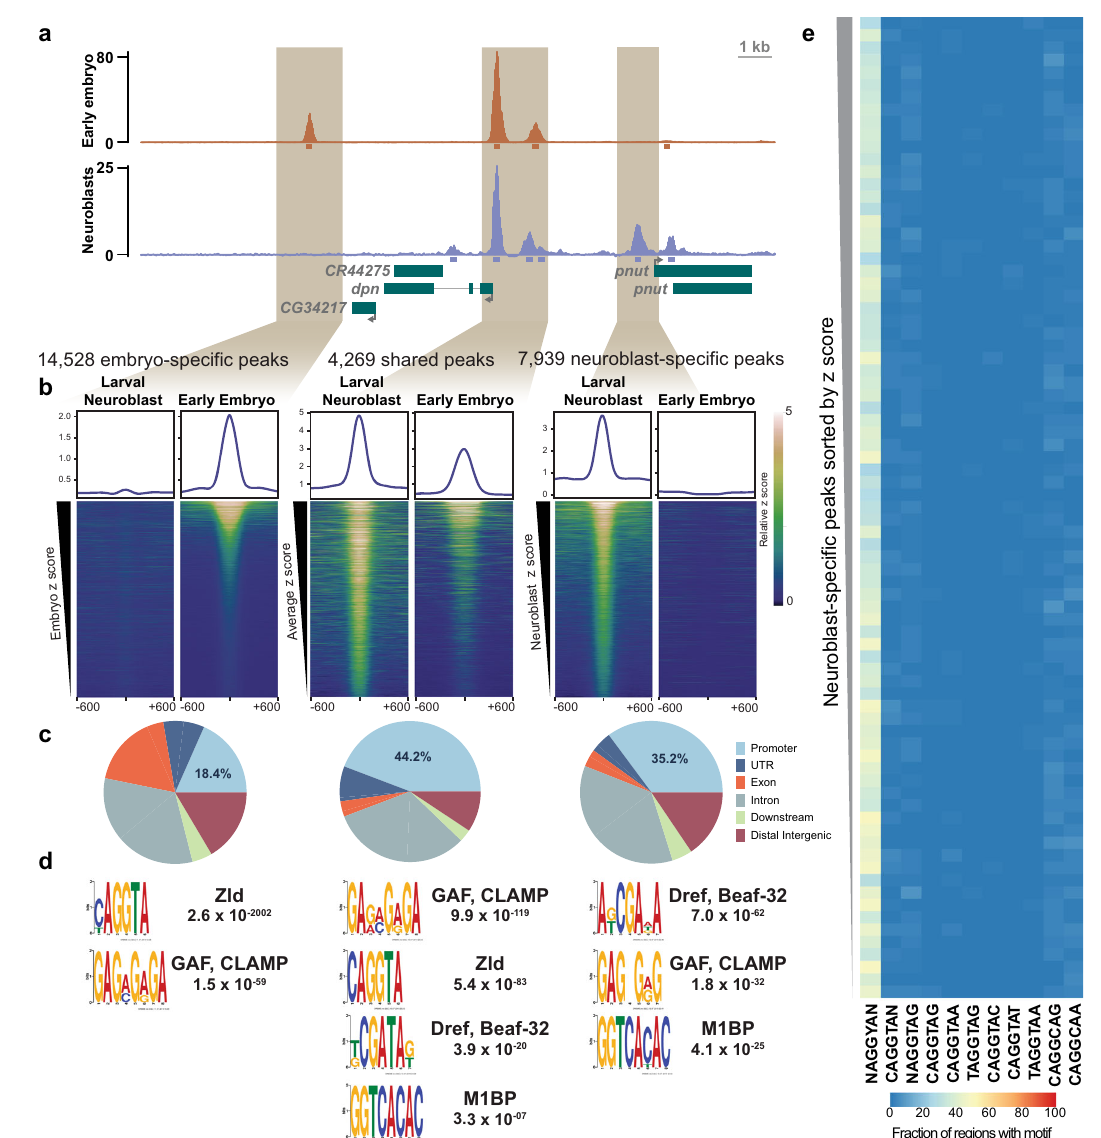
Fig. 4 Zld occupancy in type II neuroblasts is driven by a feature apart from DNA sequence. a Representative genome browser tracks for Zld ChIP-seq from stage 5 embryos 22 and brat 11/Df(2L)Excel8040 brains centered on the dpn locus. 200 bp regions surrounding the peak summits are shown below the tracks. b Heatmaps centered on the ChIP peak summit with 600 bp fl anking sequence for the embryo-speci fi c peaks ranked by embryo-speci fi c peak signal, shared peaks ranked by the average signal across the embryo and type II neuroblasts, and type II neuroblast-speci fi c peaks ranked by type II neuroblast-speci fi c peak signal. Colors indicate relative ChIP-seq z score. Average z score pro fi le is shown above each heat map. c Pie charts of the genomic distribution of Zld-binding sites in each peak class. Promoters are de fi ned as − 500 to + 150 bp from the transcription start site. d Motif enrichment for each peak class as determined by MEME-suite. The signi fi cance value is based on the log likelihood ratio, width, sites, background, and size of the input sequence. e Enrichment of Zld-binding motif variants among type II neuroblast-speci fi c Zld peaks. Peaks are sorted based on z score from highest (top) to lowest (bottom) and binned into groups of 100. Color of each cell represents the percent of peaks within each bin containing the indicated